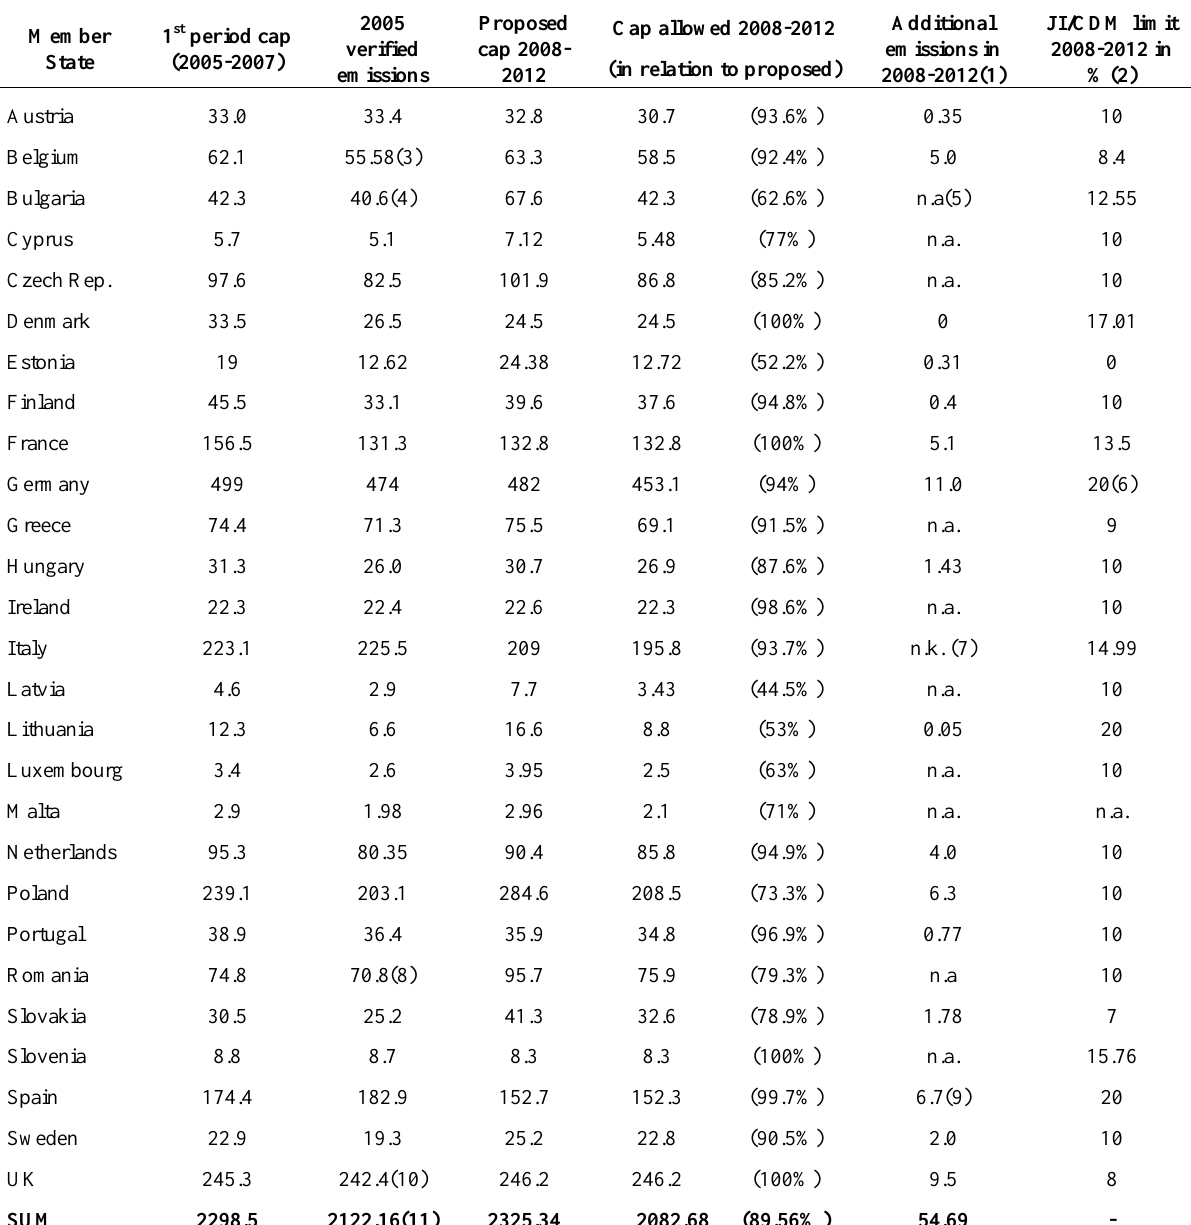
Table 2. Final Commission decision on